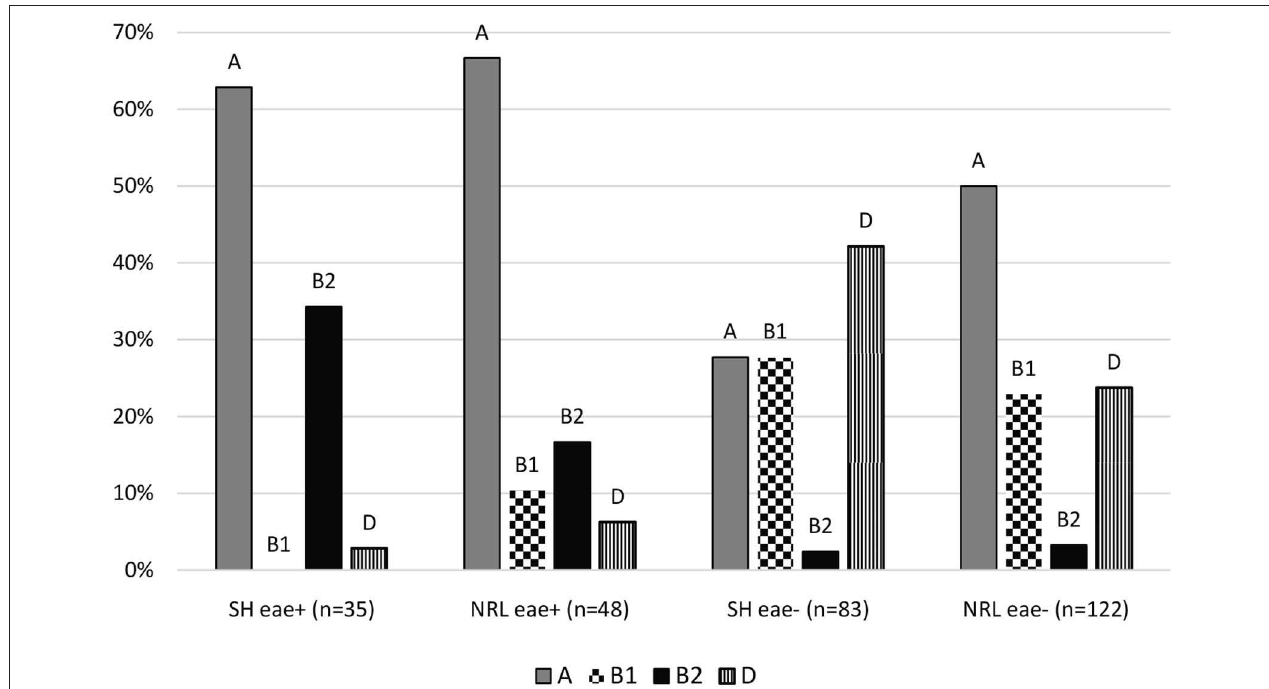
FIGURE 1 | Distribution of the phylogenetic groups of isolates. SH, slaughterhouse; NRL, National Reference Laboratory; eae, intimin gene; A, B1, B2; D, main phylogenetic groups.